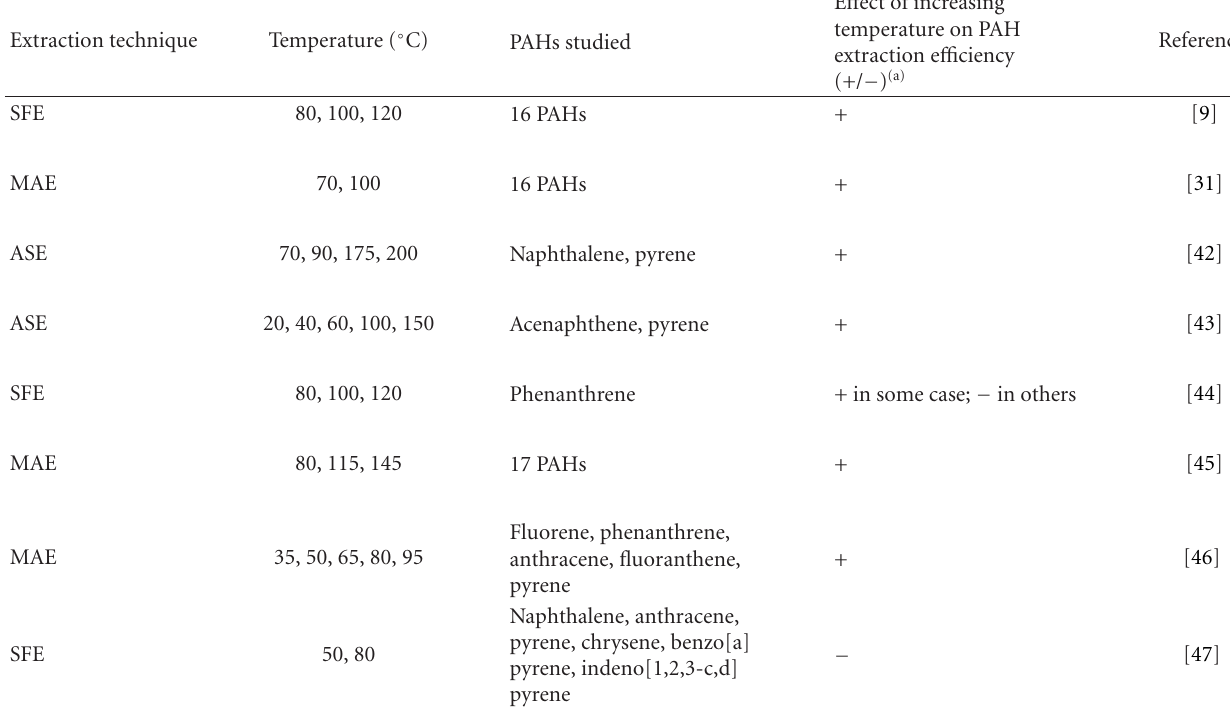
Table 1: Bibliographic compilation of studies on extraction